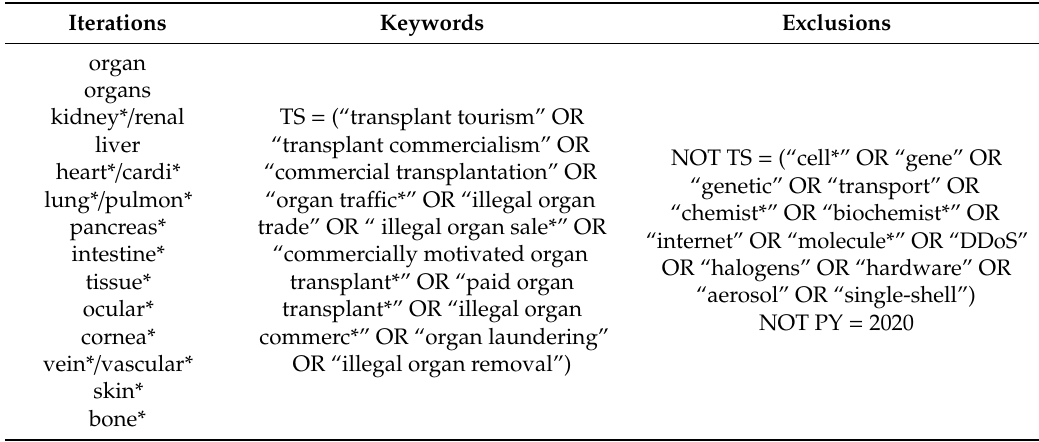
Table 1. Search strategy used in Web of Science (WoS) to retrieve